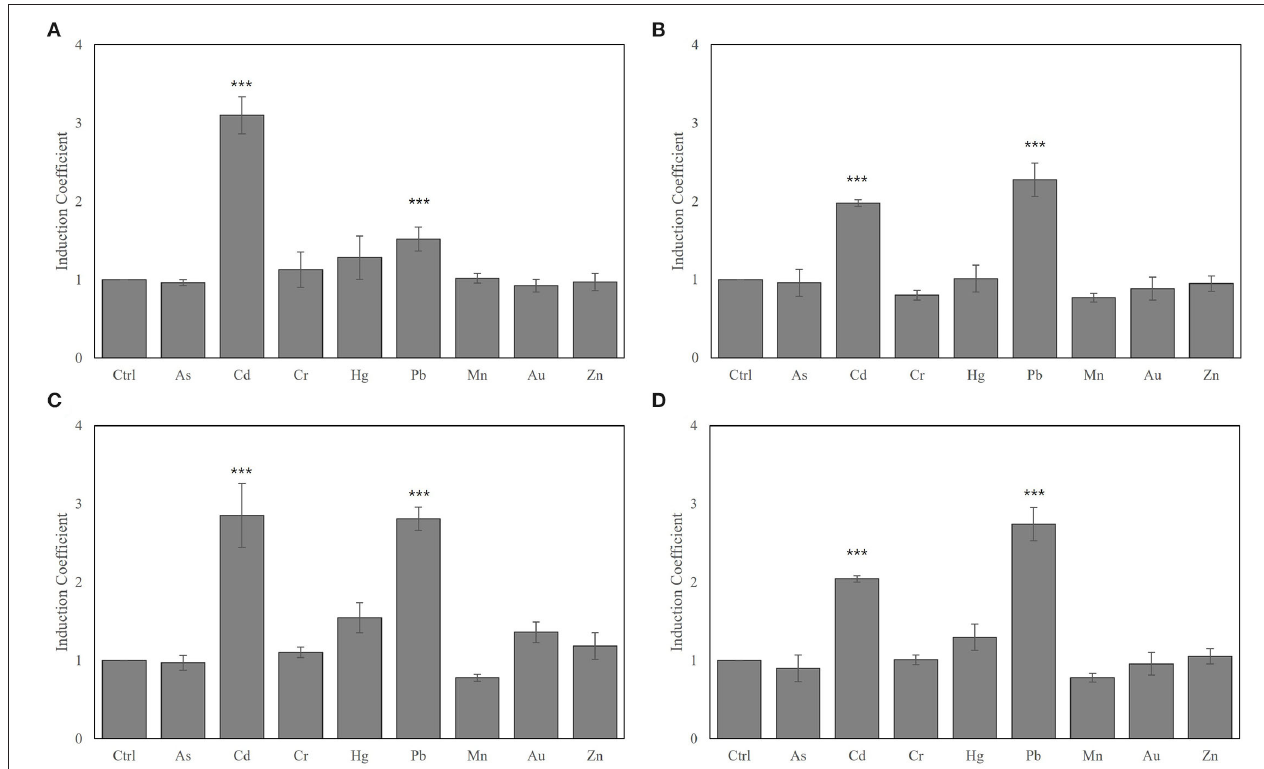
FIGURE 1 | Metal selectivity of biosensors using (A) E. coli-zntR , (B) E. coli-zntR/copA , (C) E. coli-zntR/zntA , and (D) E. coli-zntR/copA/zntA . The biosensors were exposed to 1 µ M of tested metal ions for 2h, and the eGFP expression levels were represented as induction coefficient values. The values were obtained from more than three times of replicated experiments. The asterisk means the data were significantly higher than the control (Dunnett’s test, *** p <